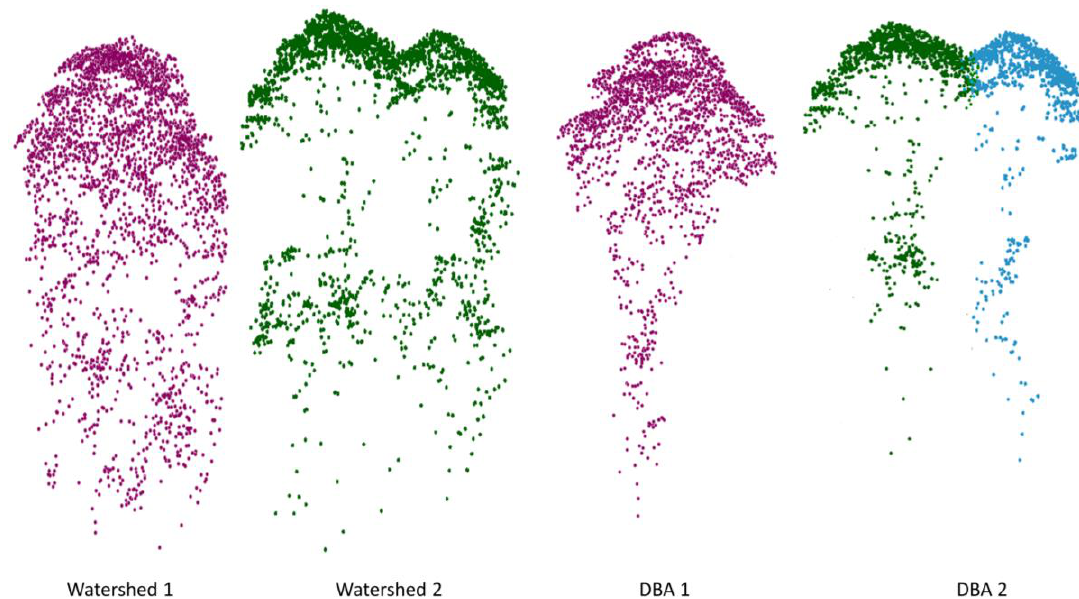
Figure 10. Comparison of watershed delineation results before and after refinement using the DBA. The two trees on the left were segmented using watershed segmentation; the two trees on the right were refined using the DBA. The refinement produced a point cloud that better represented the bole and lower portion of the tree, while the watershed segmentation delineated every point below the surface, including extraneous features that are not part of the tree. Table 2. Accuracy assessment statistics for tree segmentation using morphological watershed segmentation and the proposed method based on the distance-based algorithm (DBA) at the PFR